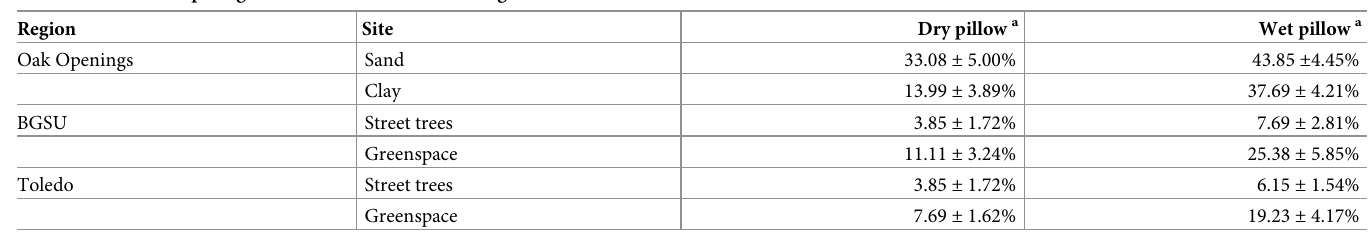
Table 1. Results comparing water demand behavior among sites. Region